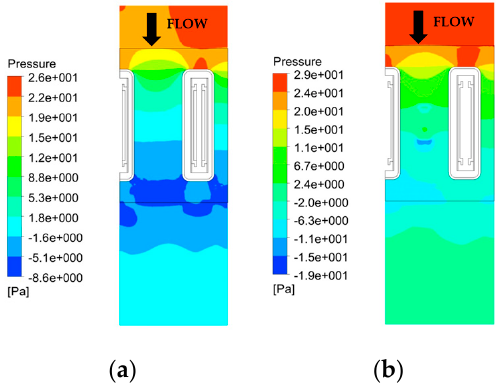
Figure 11. Pressure drop of PTC heater. ( a ) Case 1; ( b ) Case 4. Table 6. Analysis results of high voltage PTC Heater.